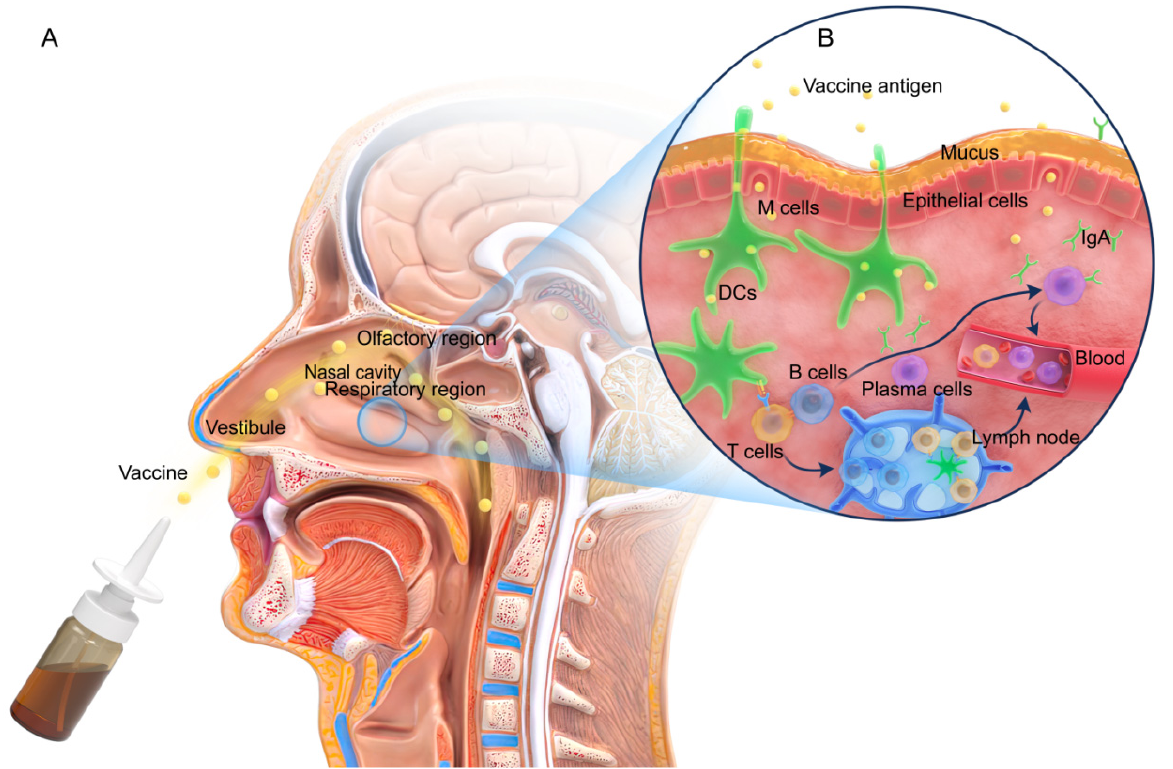
Figure 1. Nasal structure and the mucosal immune response. ( A ) Structure of the nasal cavity. ( B ) The immune response mechanism in the nasal mucosa. M cells or DCs (green) take up the antigens at the induction site, migrate to NALT, and interact with T cells (yellow) to activate B cells (blue) into plasma cells (purple). A few of the plasma cells migrate to the effector site and secrete IgA antibodies. In addition, the remaining B cells and the activated T cells pass through the blood, induce cellular and IgG-based systemic immune responses, and may even differentiate into memory B and T cells.